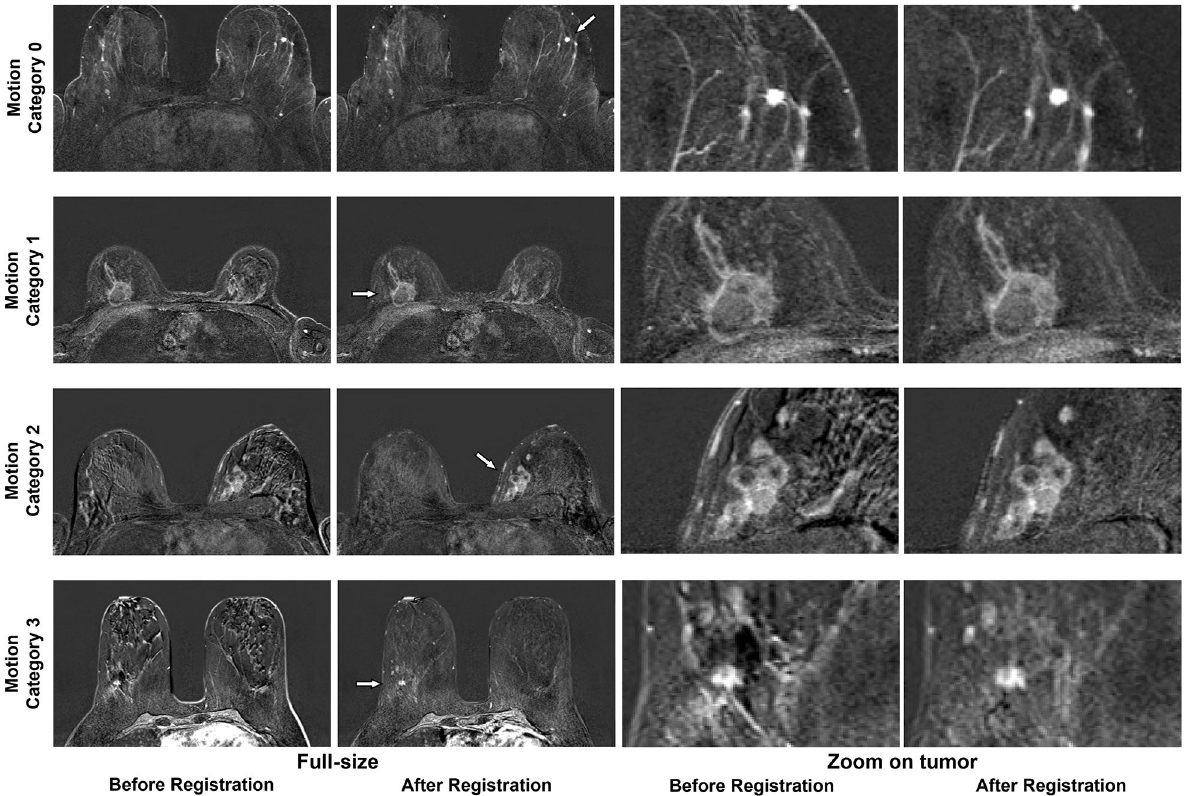
Fig. 3 Illustration of motion categories. Readers subjectively assigned images to one of four motion categories based on visual assessment. Each motion category is illustrated by an example shown at the fifth time point after contrast agent injection. The higher the initial motion category, the greater was the visually perceived impact of motion on image quality and hence, potential diagnostic limitation. The unenhanced image was subtracted from the enhanced images. Lesions are indicated by an arrow in the second column (full-size images after registration). The respective areas were enlarged and are shown in columns three and four, before and after registration,